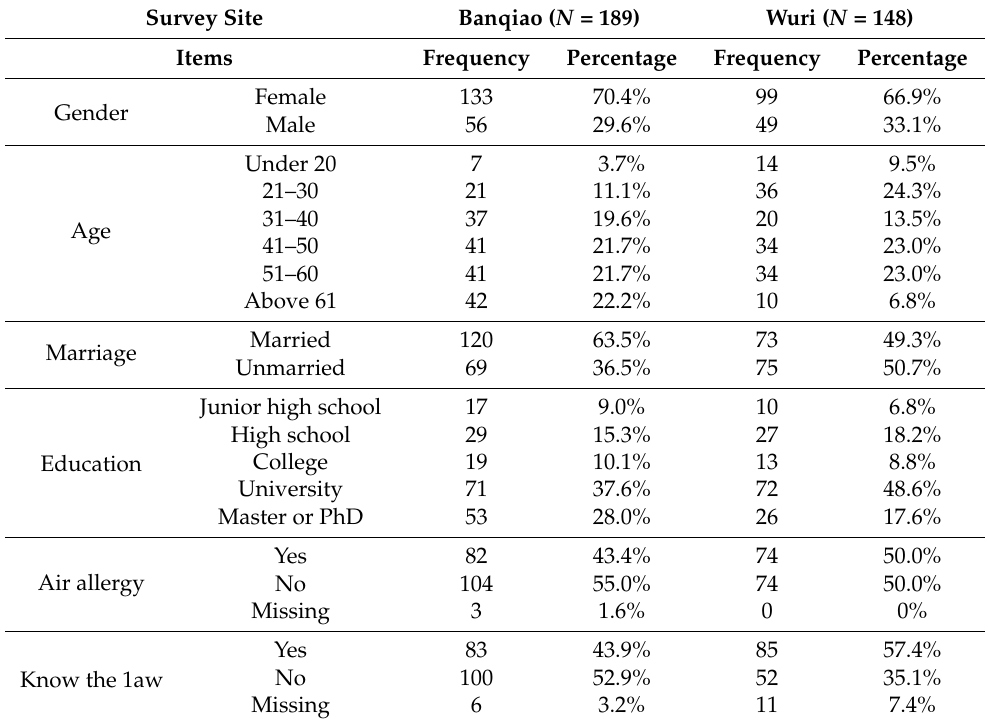
Table 5. Comparison of Banqiao and Wuri sample features.